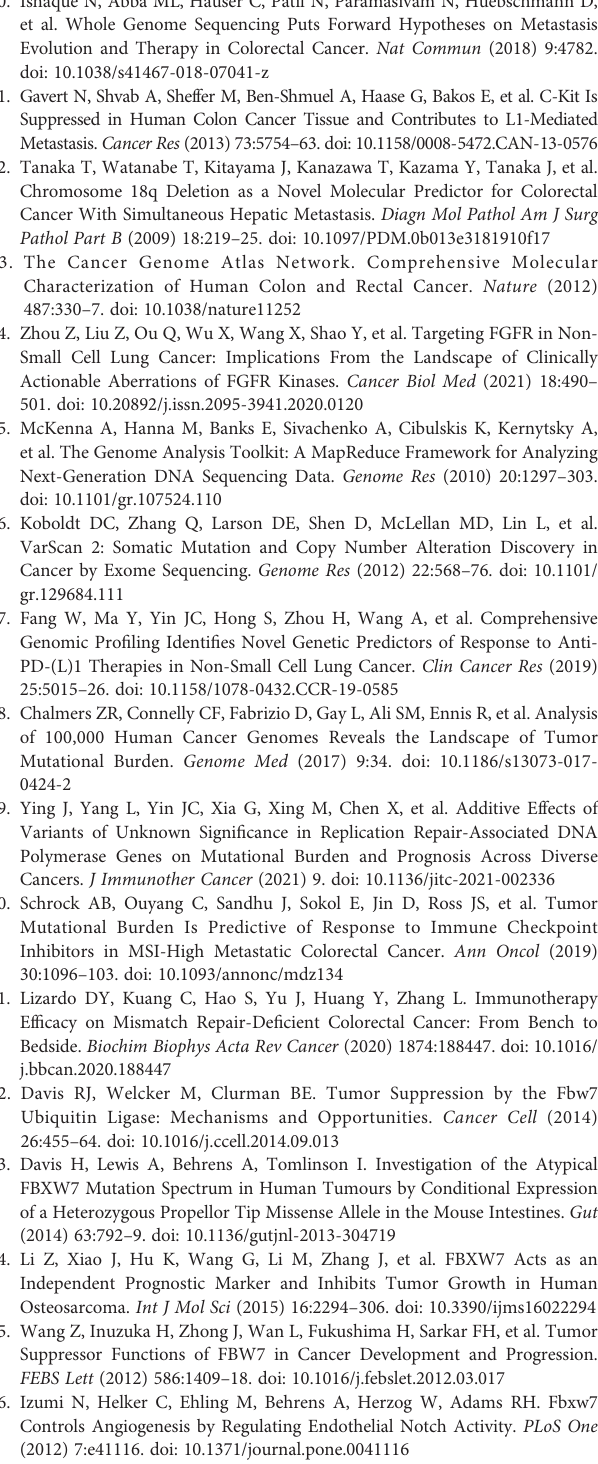
Supplementary Figure 7 | The TMB (A) and MSI (B) distribution in the Non-OM and OM groups of this study. Supplementary Figure 8 | ThecomparisonofTMBbetween FBXW7